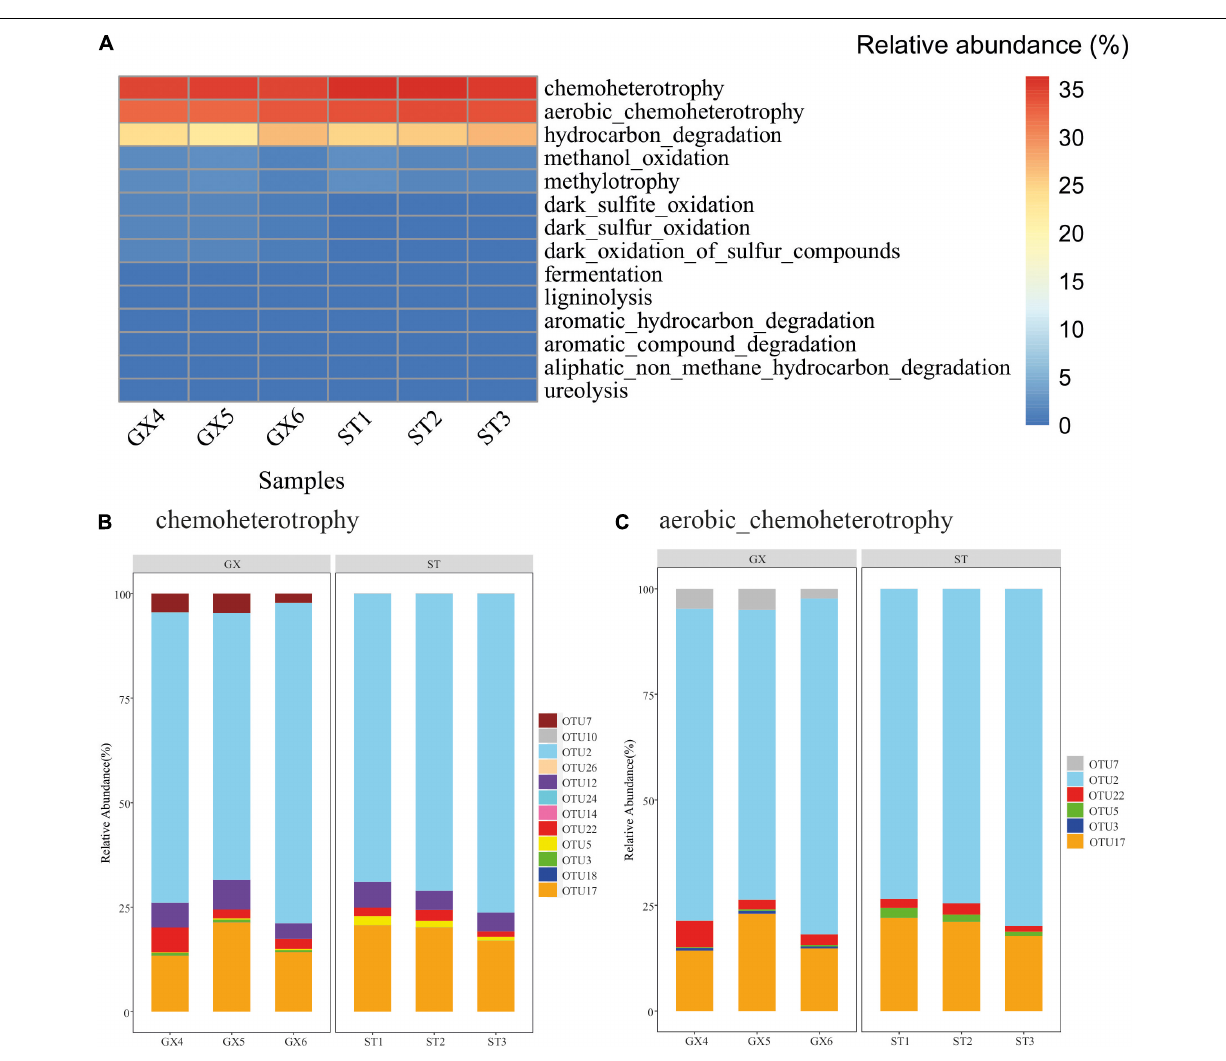
FIGURE 5 | Predicted functional groups among the bacterial communities associated with Phaeocystis globosa cultures. (A) Relative abundances of functional classifications. (B) OTUs associated with predicted chemoheterotrophic functions. (C) OTUs associated with predicted aerobic chemoheterotrophic